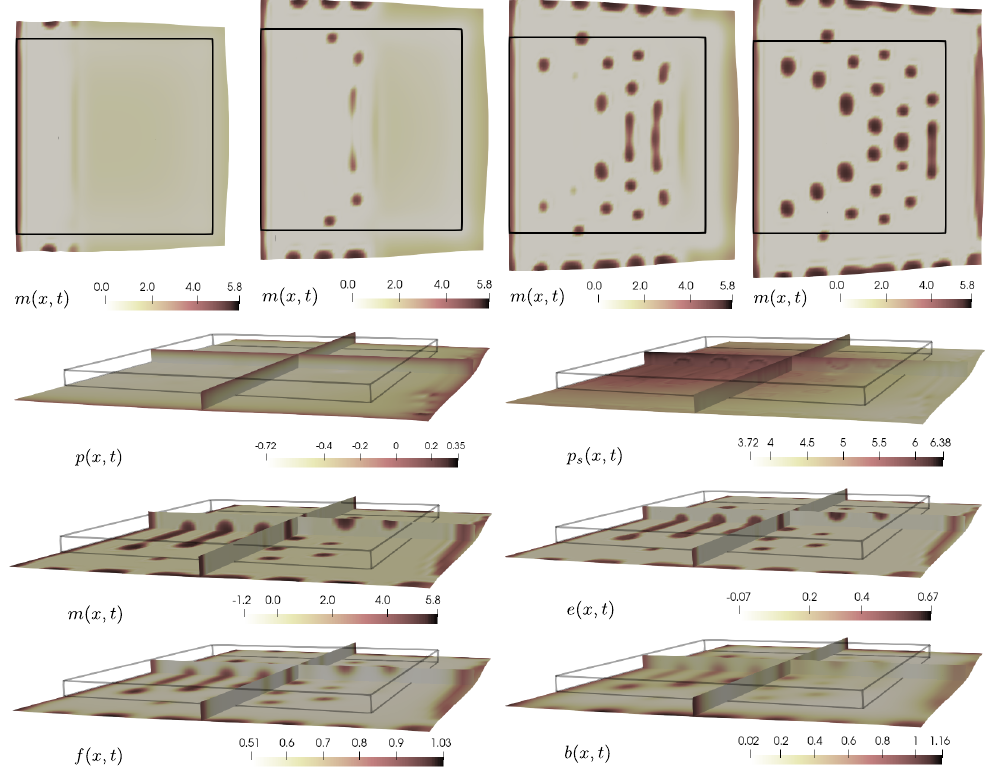
Figure 9. Evolution of the mesenchymal cell concentration under finite growth using the formu- lation (29), snapshots are taken at t = 160,280,400,520 (top). We also display the fluid and solid pressures (second row), the mesenchymal and epithelium concentrations (third row), and the FGF and BMP (fourth